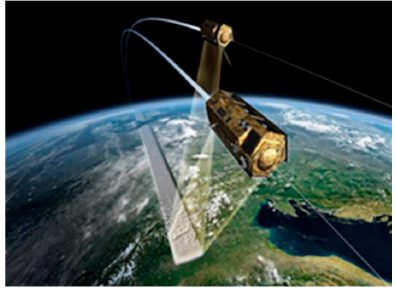
Figure 26. Configuration of TanDEM-X bistatic system.